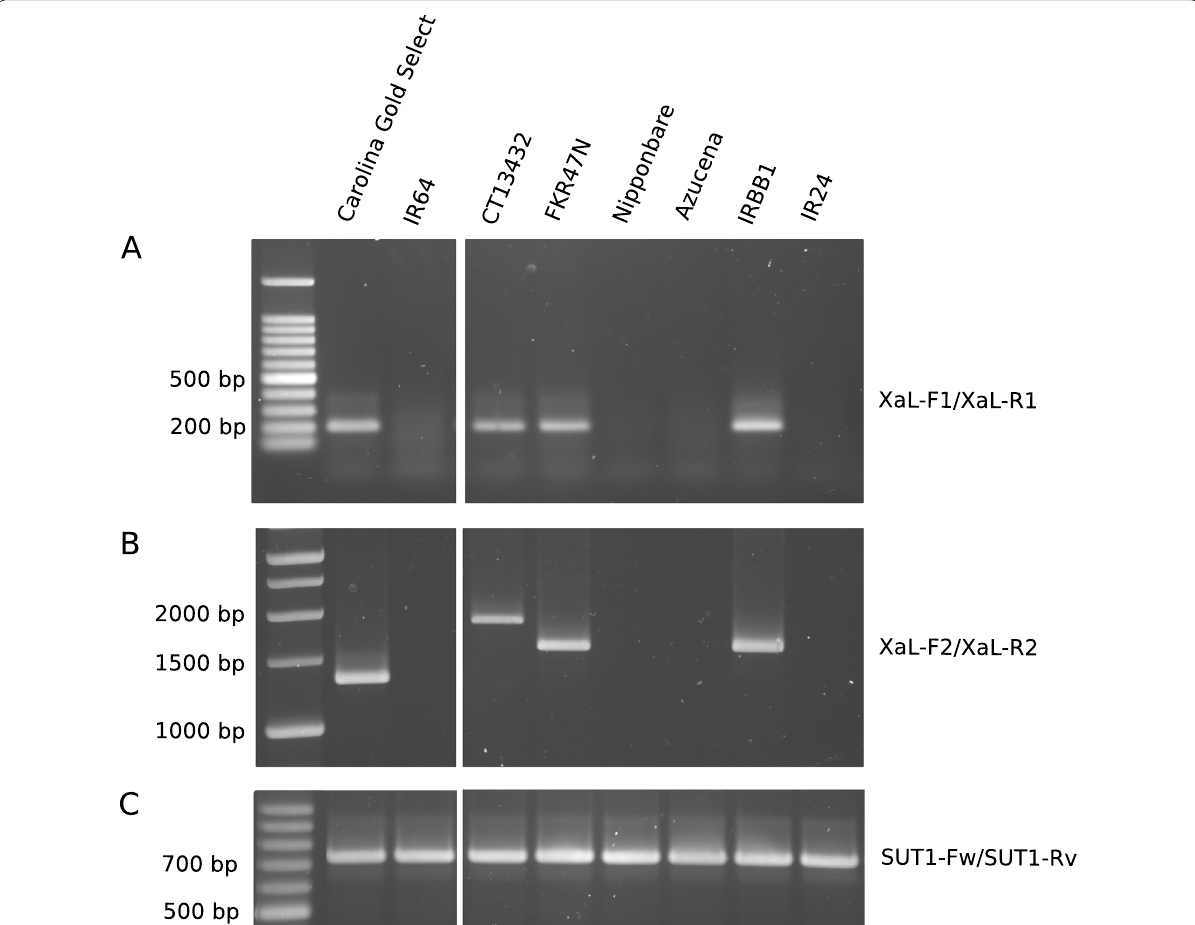
Fig. 3 The rice varieties CT13432 and FKR47N carry distinct apparent alleles of Xa1 . The genomic DNA of rice varieties Carolina Gold Select, IR64, CT13432, FKR47N, Nipponbare, Azucena, IRBB1 and IR24 were used as a template for PCR amplification of A the junction of the first repeat of 279 base pairs of Xa1 and its upstream region, B the whole repeat region of Xa1 and alleles, and C the housekeeping gene OsSUT1 used as a control. All the samples were run on the same